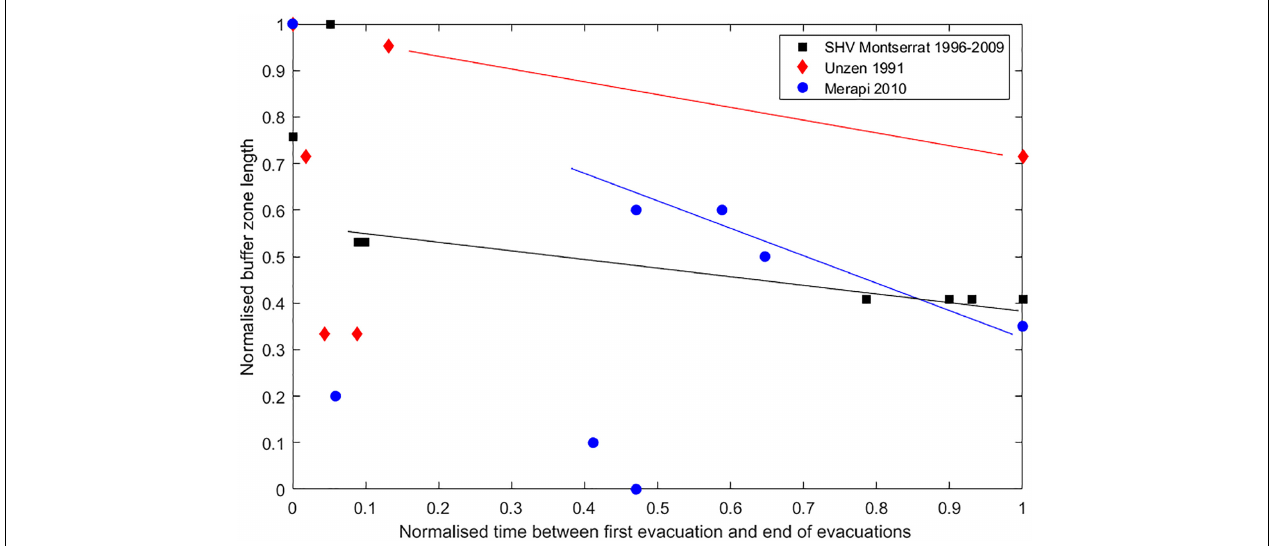
FIGURE 4 | Normalized buffer zone length against normalized duration of eruption for three eruptions that experienced staged evacuations. The normalized buffer zone length is the ratio of the length of the buffer zone (the shortest distance between the active surface flows and a non-evacuated population), and the maximum length of the buffer zone at any point during the eruption. The buffer zone length changes over time with both the volcanic activity and decisions to evacuate and reoccupy different 15 areas. The maximum buffer zone length and duration of the eruptions are 2.1 km and 4 months for Unzen, 6.6 km and 13 years for SHV and 10.0 km and 16 days for Merapi. Normalized data show that trends in buffer zone length changes over eruption duration are similar for eruptions of very different